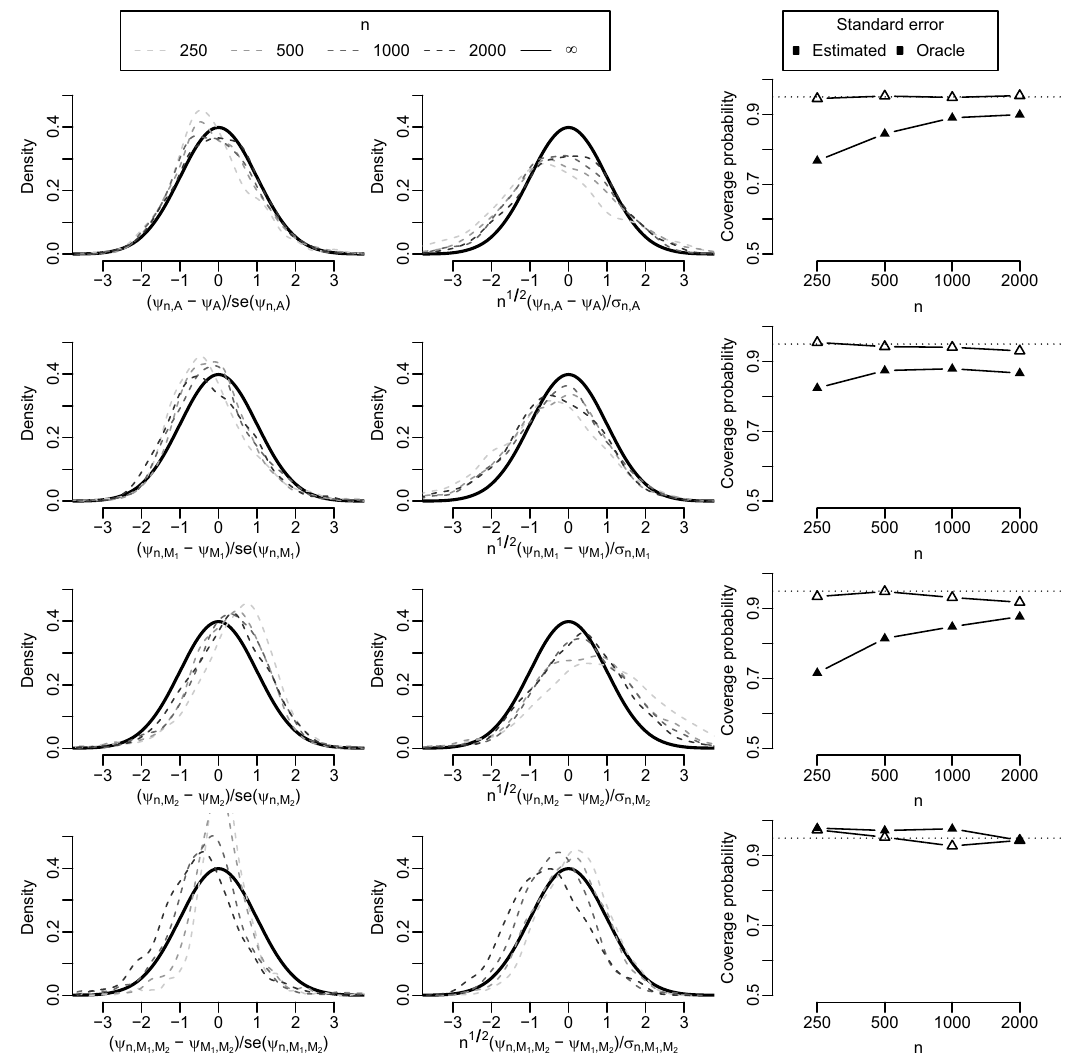
Figure 6: Illustration of weak convergence and Wald - style con fi dence intervals based on the one - step estimator that discretized mediator distributions into ten bins. The left two columns show the kernel density estimate of the sampling distribution of the centered estimates of interventional e ff ects scaled by the oracle standard error ( left ) and by their estimated standard error ( middle ) . In each case, the asymptotic distribution is shown in black. The right panel shows coverage probability of a nominal 95% Wald - style con fi dence interval based on an oracle standard error ( solid triangle ) and an estimated standard error ( open triangle )